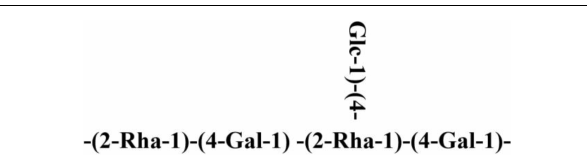
FIGURE 6 | Schematic diagram of polysaccharide K-CMLP. respectively. Combining with the results of monosaccharide composition ( Figure 5B ), it was concluded that these three anomeric hydrogens belong to β -Gal p , α -Rha p, and α -Glc p , respectively, and the chemical shifts of β -Gal p , α -Rha p, and α -Glc p of 13 C NMR were δ 101.1, δ 98.5, and δ 96.1 ppm,